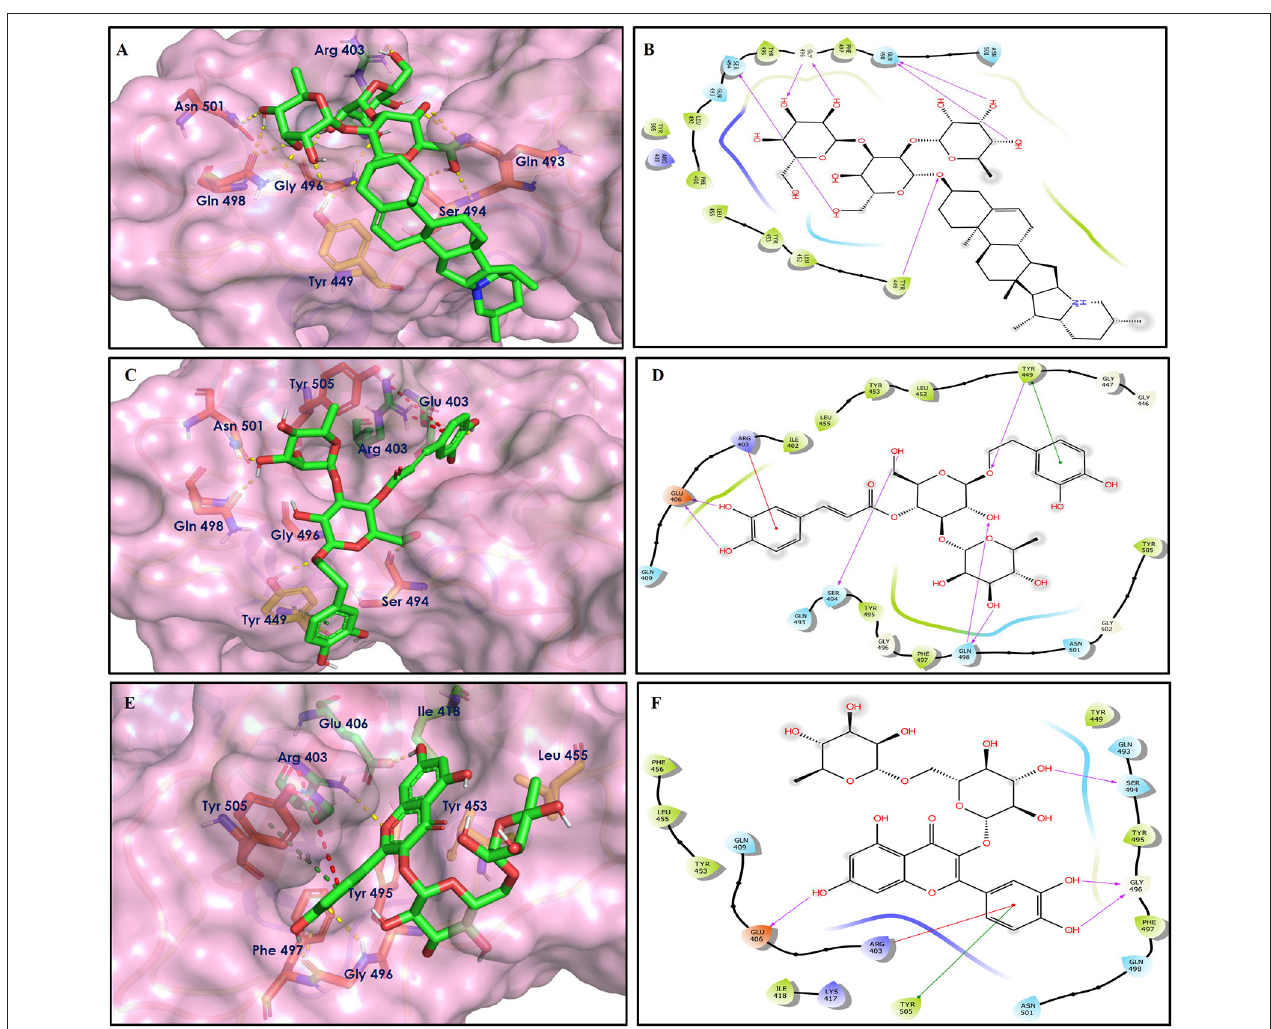
FIGURE 7 | Docking interactions of compounds (4, 2, 3 : A–F) in the active sites of Spike RBD. (A,C,E) 3D-binding mode of compounds 4 , 2 , and 3 with Spike RBD active site, respectively. Ligands are shown as green sticks, Spike RBD residues are shown as atom type color sticks, hydrogen bonds formed between ligands and receptor are depicted as yellow dotted lines, π - π stacking interaction as green dotted lines and π -cation interaction as red dotted lines. (B,D,F) 2D-ligand interaction diagram of compounds 4 , 2 , and 3 with Spike RBD active site,